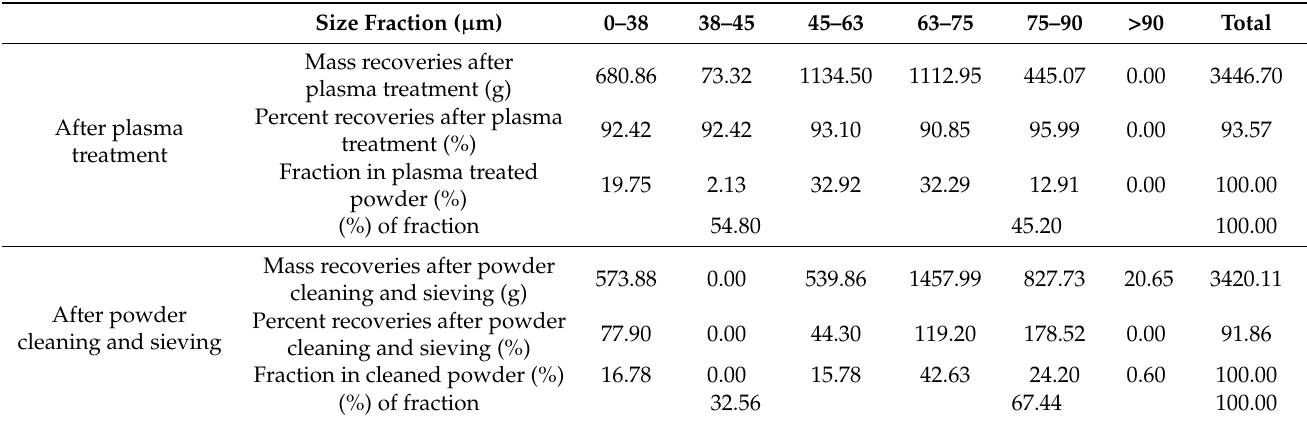
comparable to atomization methods. Table 3. Summary of the powder distribution from the bulk test after plasma treatment and the powder quantities after powder cleaning and